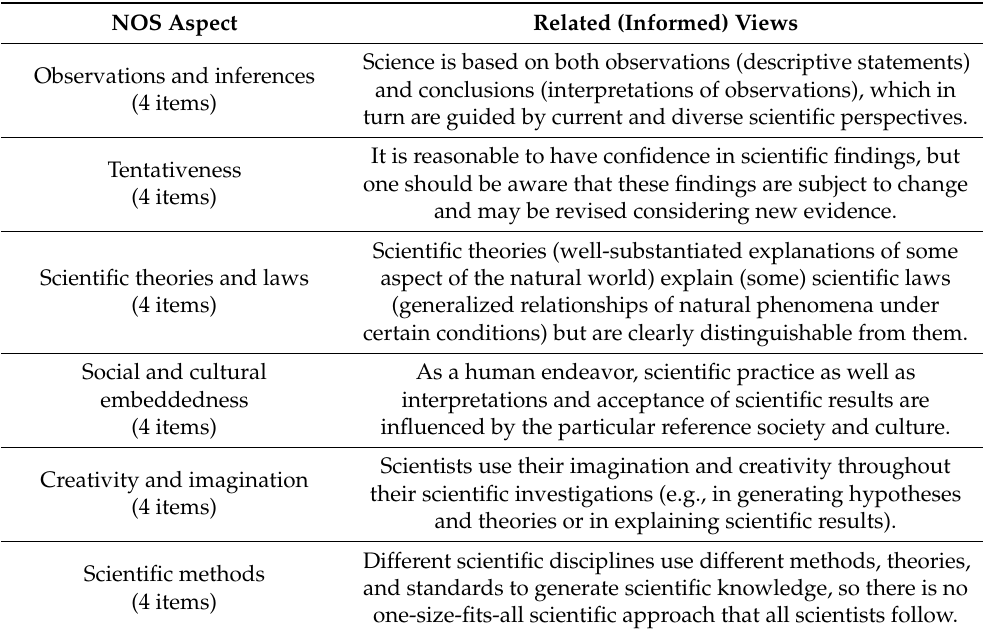
Table 2. NOS aspects covered by the SUSSI